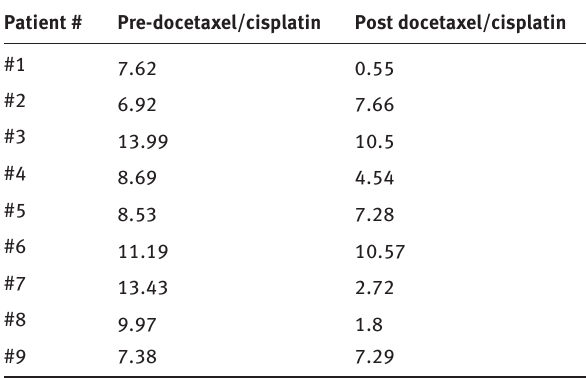
Table 3: Change in AchR-Ab